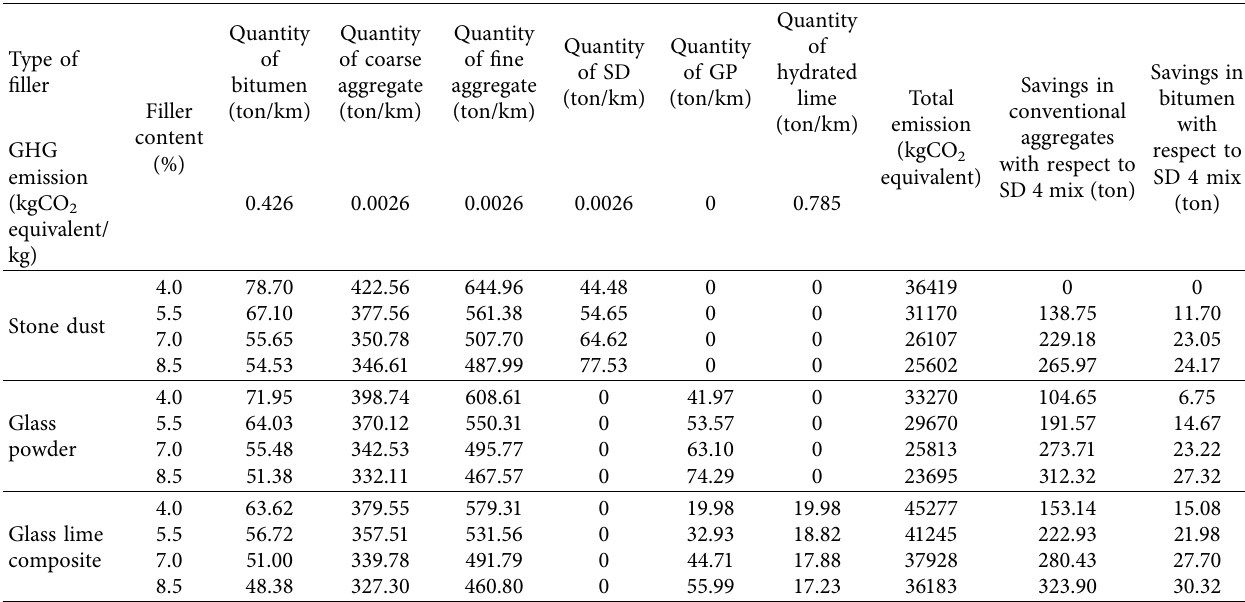
Table 9: Global warming potential of various mixes.